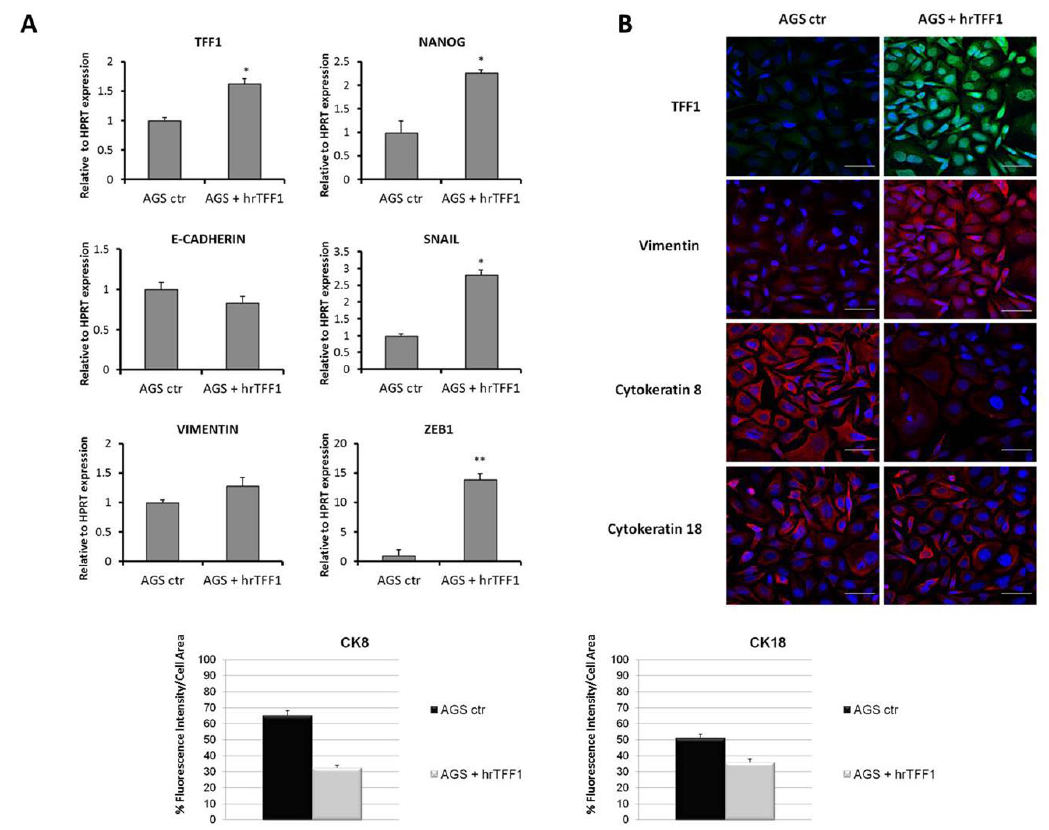
Figure 3. Effect of recombinant TFF1 on EMT markers expression in AGS cells. ( A ) mRNA expression of TFF1, Nanog, E-cadherin, Snail, vimentin, and ZEB1 detected and quantified by real-time PCR and correlated to the value of HPRT mRNA expression in AGS cells treated or not with hrTFF1 (4 μg/mL) for 72 h. * p < 0.05 and ** p < 0.01 vs. the untreated control; ( B ) Immunofluorescence analysis to detect TFF1, vimentin, and cytokeratin-8 and -18 on AGS cells treated or not with hrTFF1. Immunofluorescence images refer to 72 h after treatment. Nuclei were stained with DAPI. Magnification 63×. Bar = 10 μm; ( C ) Quantification of cytokeratin-8 and -18 as percent of fluorescence intensity per cell area from corresponding panels in Figure 3C. Statistical analyses for significance of results were performed using Student’s t -test, assuming a two-tailed distribution and unequal variance. * p < 0.05, ** p < 0.01.